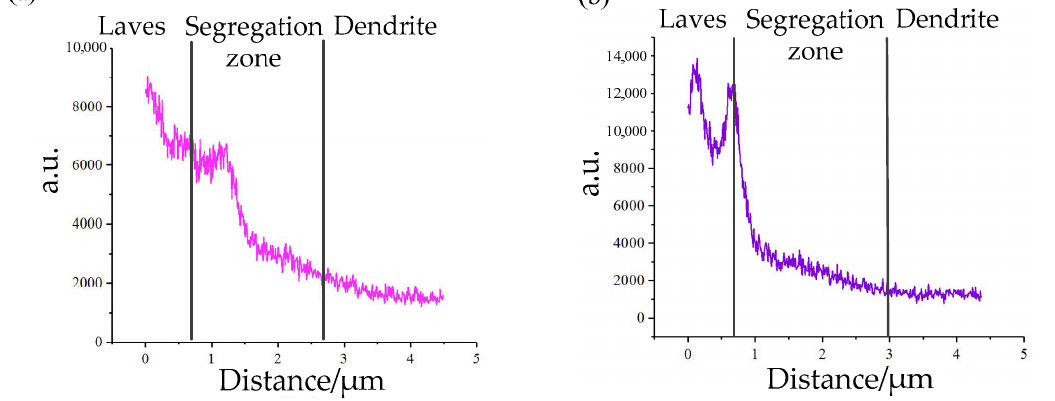
Figure 10. The distribution of Nb in ( a ) No.1 alloy and ( b ) No.2 alloy.